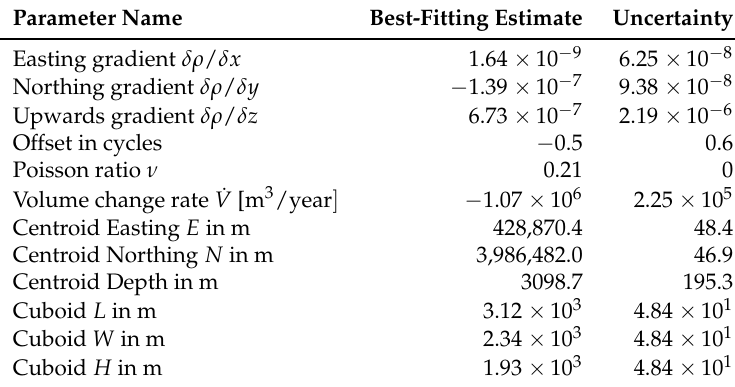
Table 3. Results from nonlinear inversion with a “cuboid” parameterization on the stack of Sentinel-1A pairs spanning 2014 to